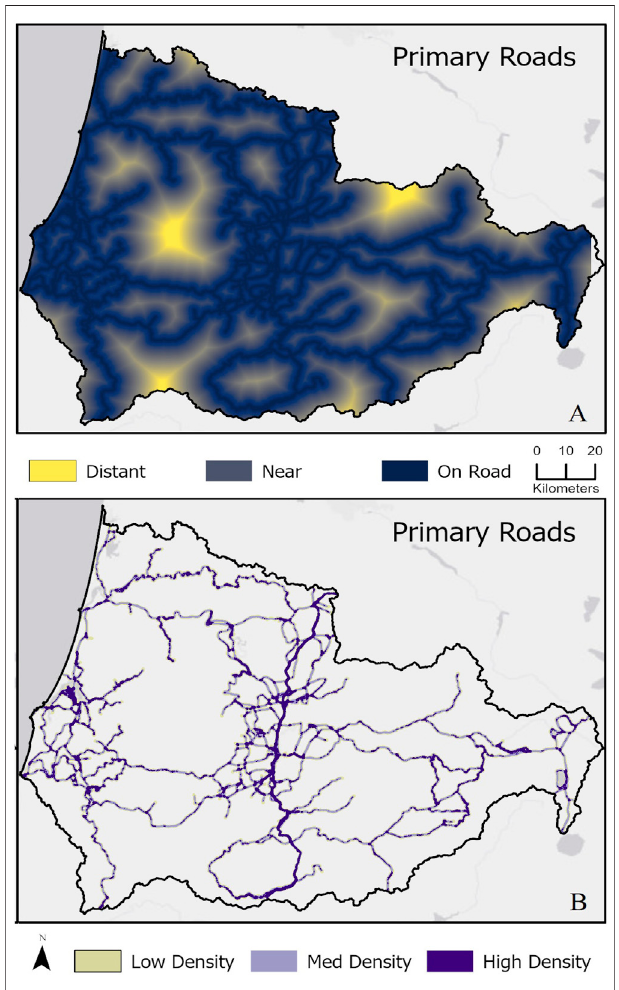
FIGURE 2 | Road density maps illustrating (A) the greatest Euclidian distance from the road for primary roads and (B) primary road densities per 1 km 2 area categorized as low, medium, and high density. For (A) yellow shows areas that are furthest from roads whereas dark blue is adjacent to roads; outputs were calculated using Euclidean distance geometry, symbolized using 3-class categories for simplicity (distant from roads, near/ adjacent to roads, on the road). For (B) outputs used focal statistics to calculate the relative density, symbolized using 3-class quantiles for simplicity (low, medium, and high-density roads). Raw values ranged from 1 to